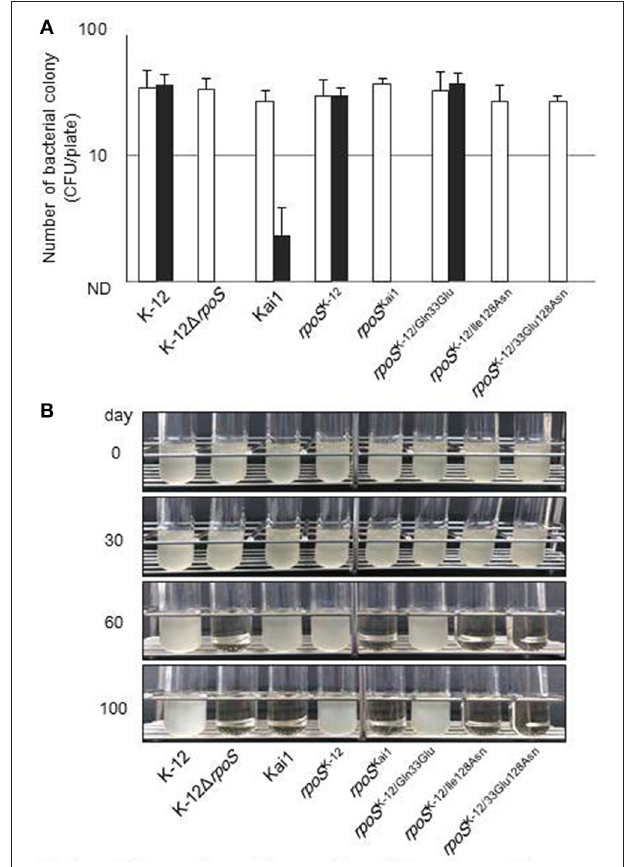
FIGURE 5 | Effect of substitution of the amino acid at residue 128 on bacterial stress sensitivity. (A) Bacteria were treated with 20 mM H 2 O 2 aqueous solution, incubated at 25 ◦ C for 2 h, and then plated on LB agar for enumeration of bacterial counts to determine survival after H 2 O 2 exposure. Filled columns, treated with H 2 O 2 ; open columns, untreated control. Mean values are shown ( n = 3). Error bars represent standard deviations. (B) Bacteria were cultured on LB agar at 37 ◦ C for 16 h and incubated at 4 ◦ C during the study period. Cold-stressed bacteria were cultured in LB broth at 37 ◦ C for 24–48 h to determine survival after cold-stress exposure. The experiment was conducted in triplicate, and typical images are shown. The statistical significance of the differences is tabulated in Table